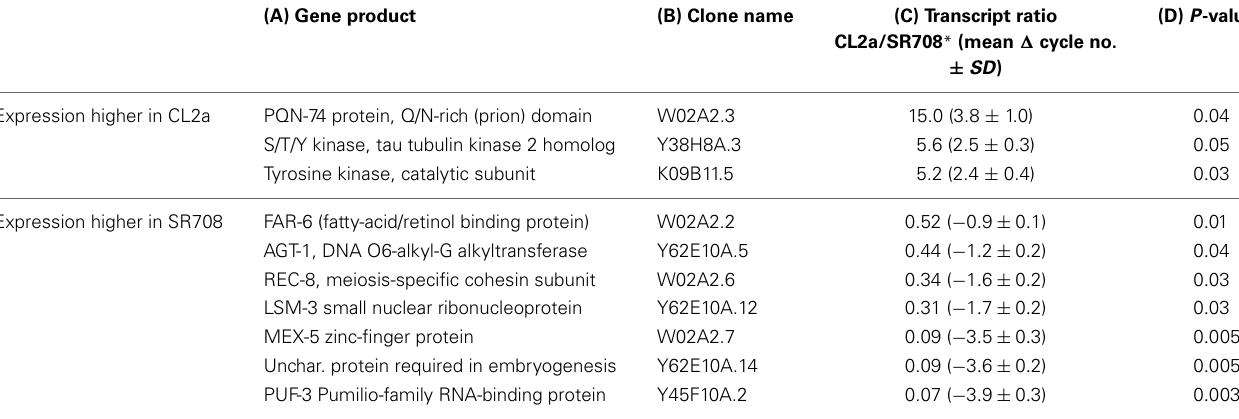
Table 3 | Genes in the lsq4 interval for which transcript level depends on the lsq4